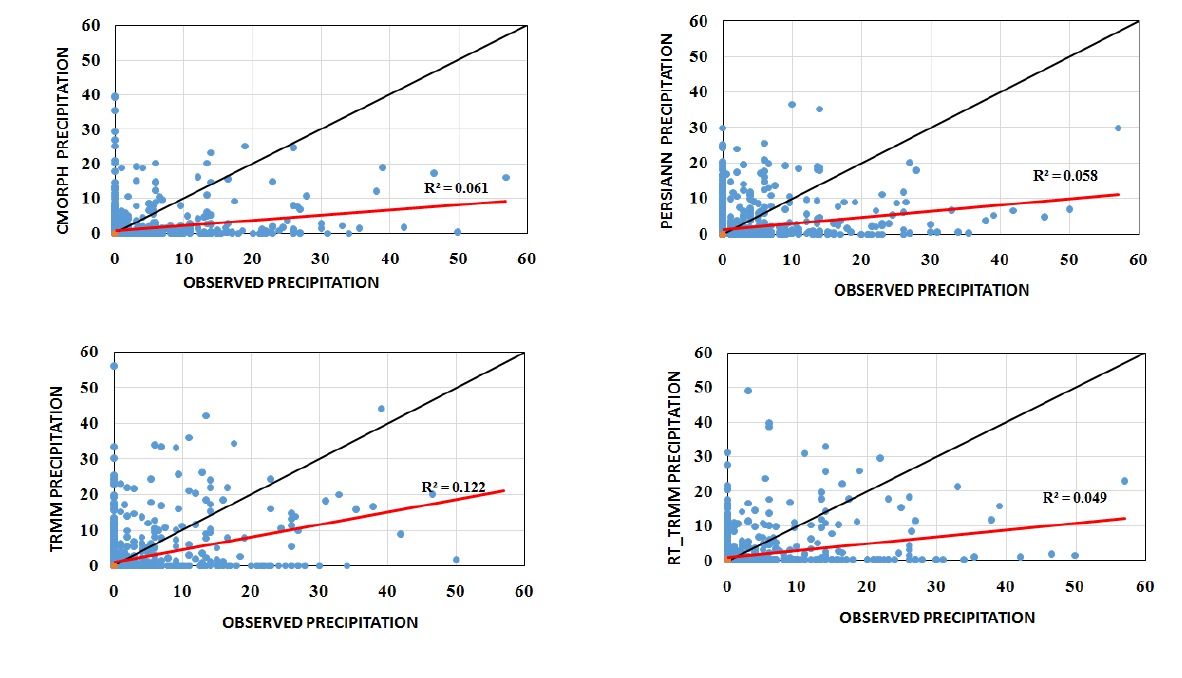
Figure1: Daily precipitation of Tamer station along with precipitation reported by satellite data station